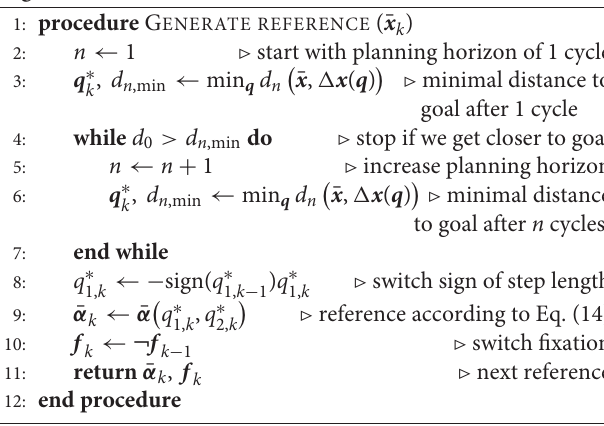
Algorithm 1 : Gait Pattern